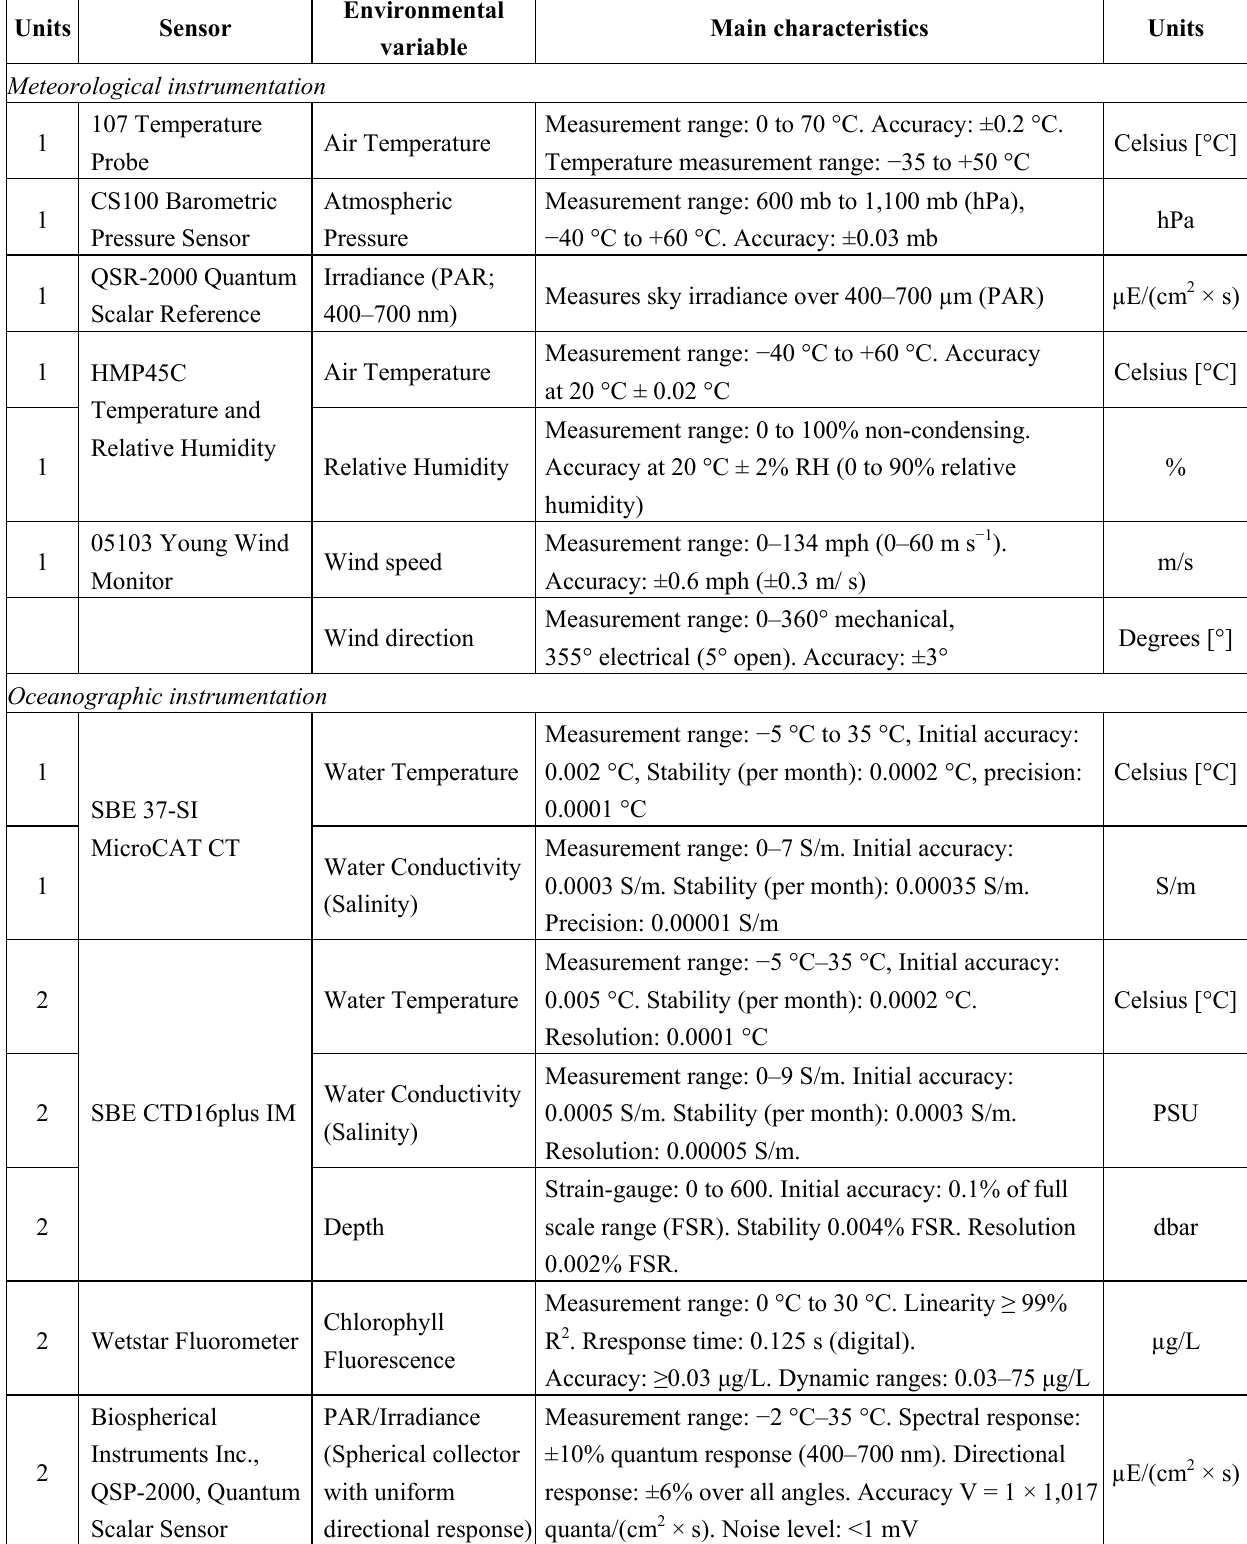
Table 1. Meteorological and oceanographic sensors installed on the